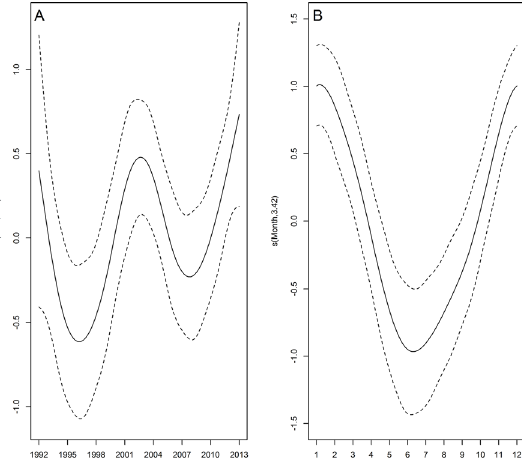
Fig 6. Temporal trends in common bottlenose dolphin strandings. Estimated smooth function (solid line) with 95% confidence interval (dashed lines) for the fitted GAM by year (A) and month (B) from 1992 to 2013. Y-axis = fitted function with estimated degrees of freedom in parentheses.